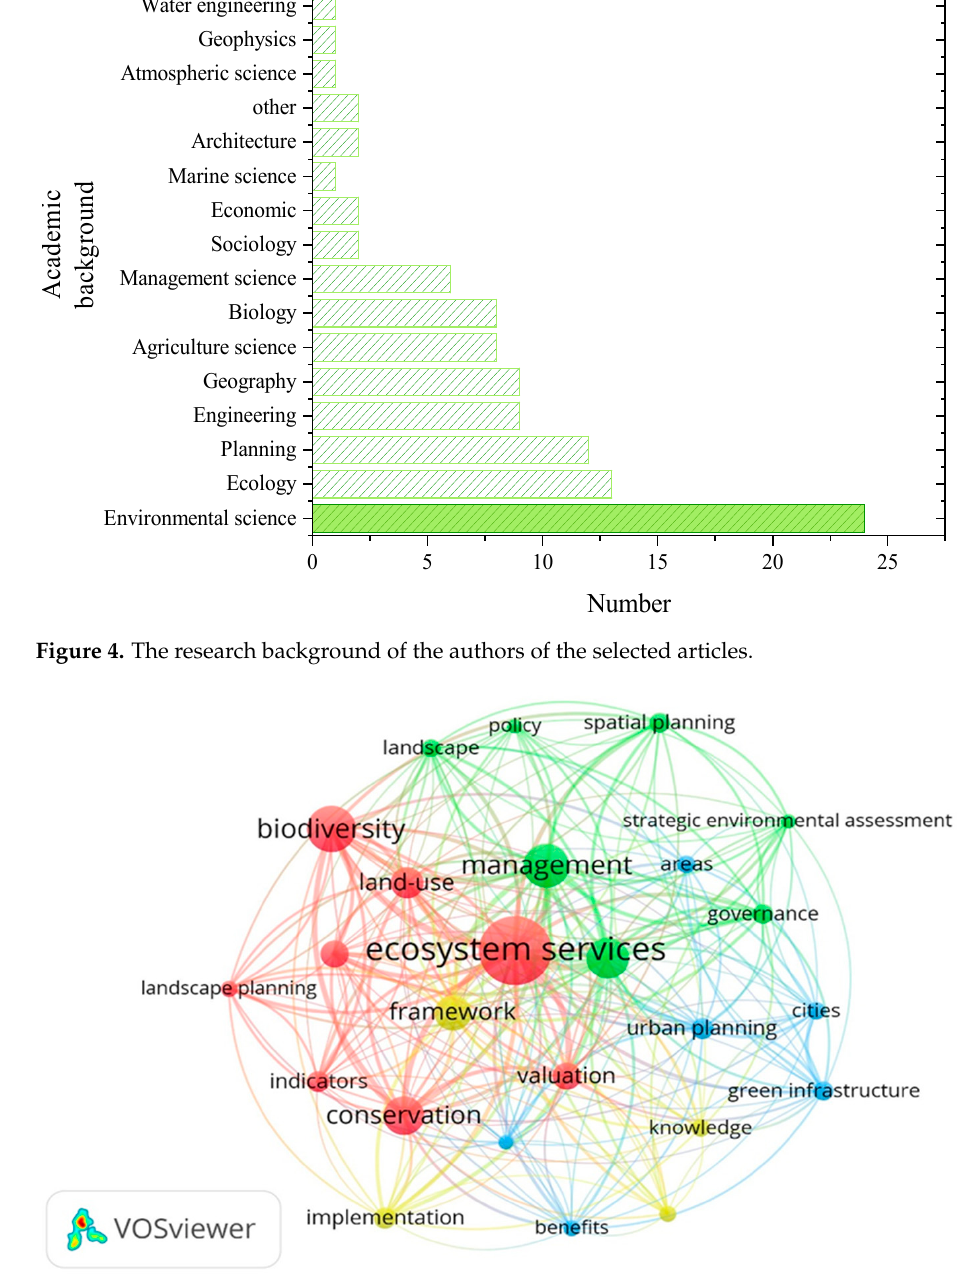
Figure 5. Results of the visualization co-occurrence analysis. Circle sizes depend on the weight of the item and different colors represent the different clusters of keywords.